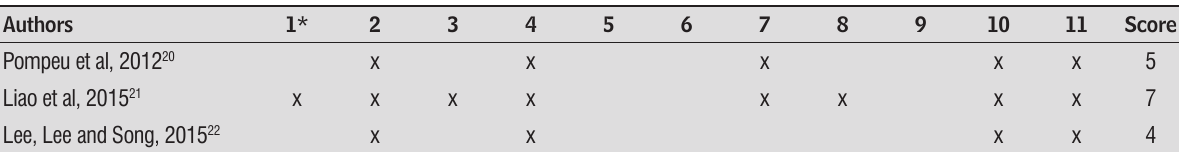
Table 2 - Methodological quality of the study by PEDro scale